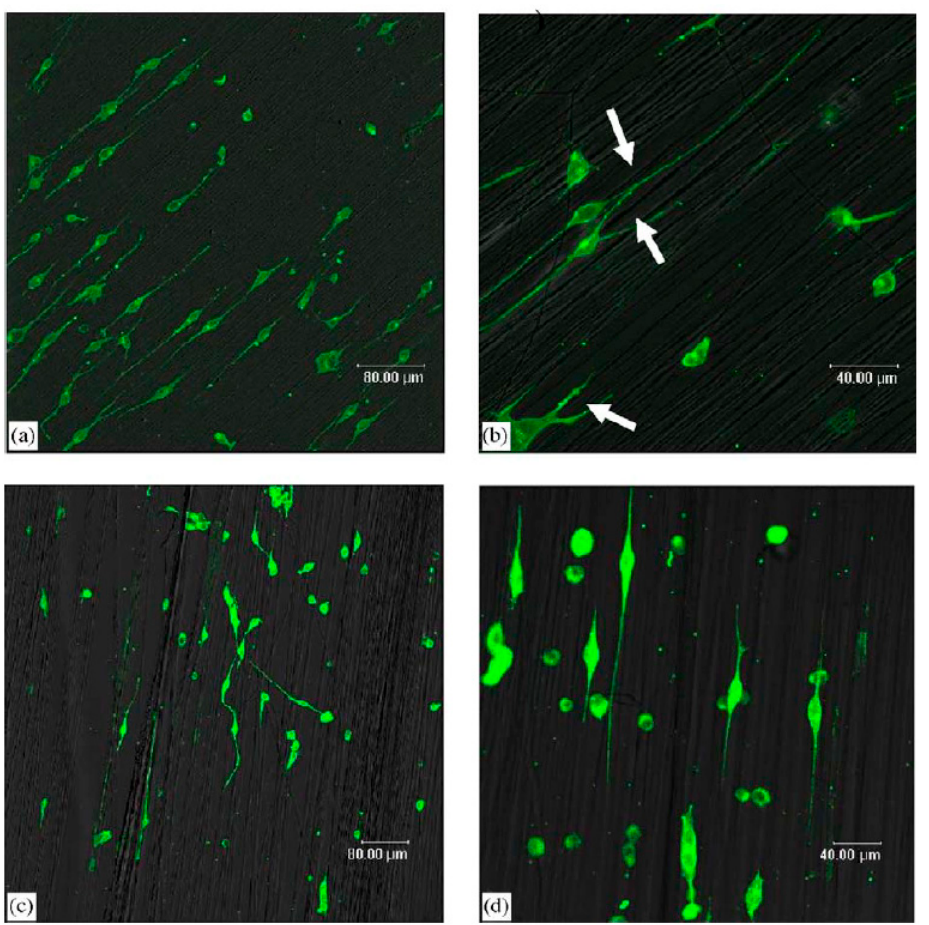
Figure 2. Laser scanning confocal microscopy micrographs of immunostained neurofilament 200 kD in neuronal stem cells after 2 days of culture; ( a ) on aligned nanofibers, low magnification (×200); ( b ) on aligned nanofibers, high magnification (×400); ( c ) on aligned microfibers; low magnification (×200) and ( d ) on aligned microfibers, high magnification (×400) Reprinted from [62] with permission from Elsevier.